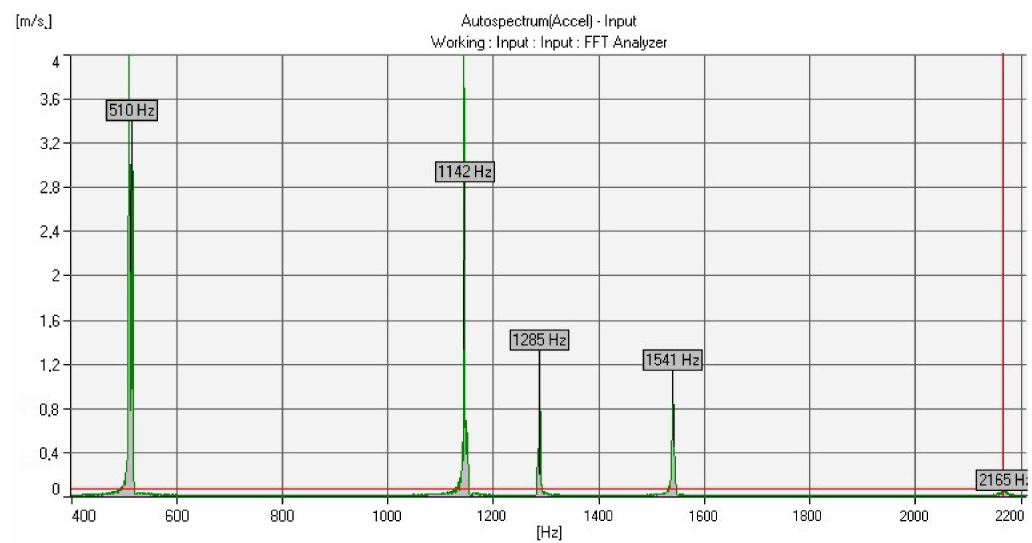
Figure 15. Experimental frequency analysis results—aluminum